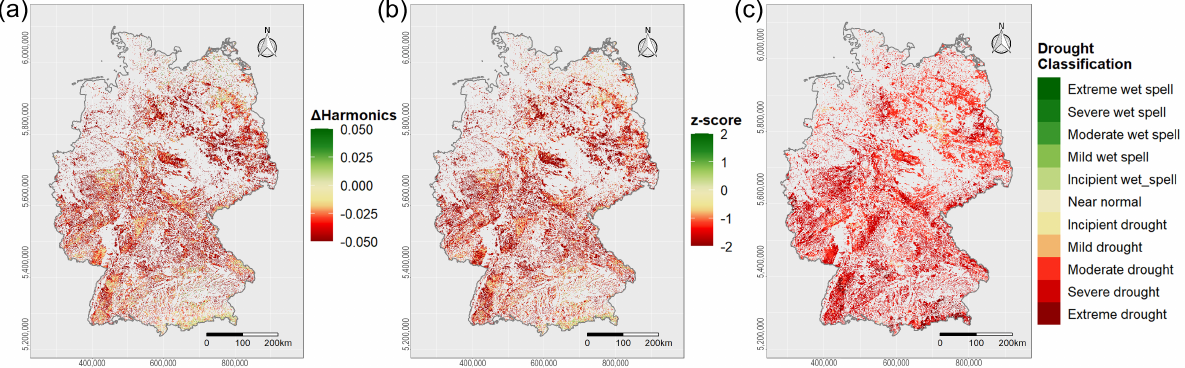
Figure 8. Drought maps derived from ( a ) MODIS NDVI ∆ Harmonic, ( b ) MODIS NDVI z-score and c) scPDSI values for German forests in August